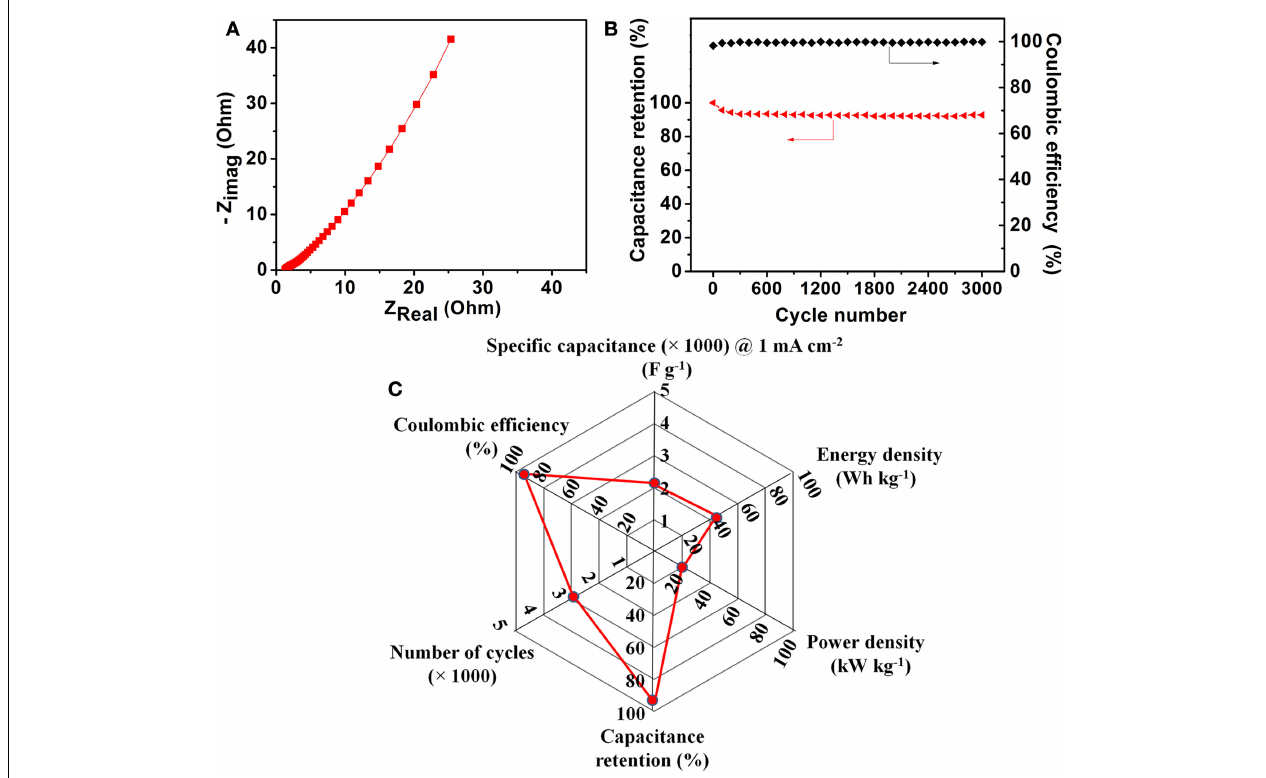
FIGURE 5 | (A) Nyquist plot for the Ni–Co–Mn oxide nanoneedle electrodes recorded from 0.1Hz to 1MHz. (B) Charge/discharge cycling stability test at a current density of 10mAcm -2 and coulombic efficiencies during the test. (C) A radar plot to summarize the electrochemical performance of the Ni–Co–Mn oxide nanoneedle